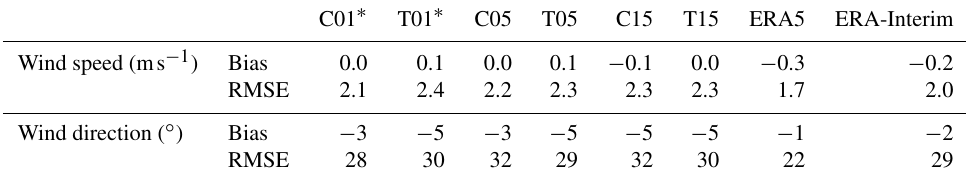
Table 8. Bias and RMSE for wind speed and direction compared to lidar measurements during December 2015 and January 2016.